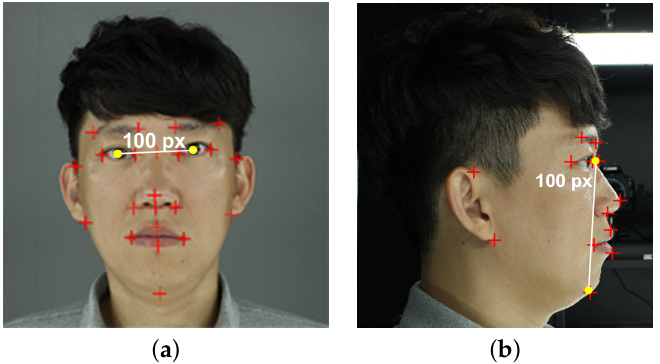
Figure 7. Example of size normalization: ( a ) frontal pose; ( b ) side